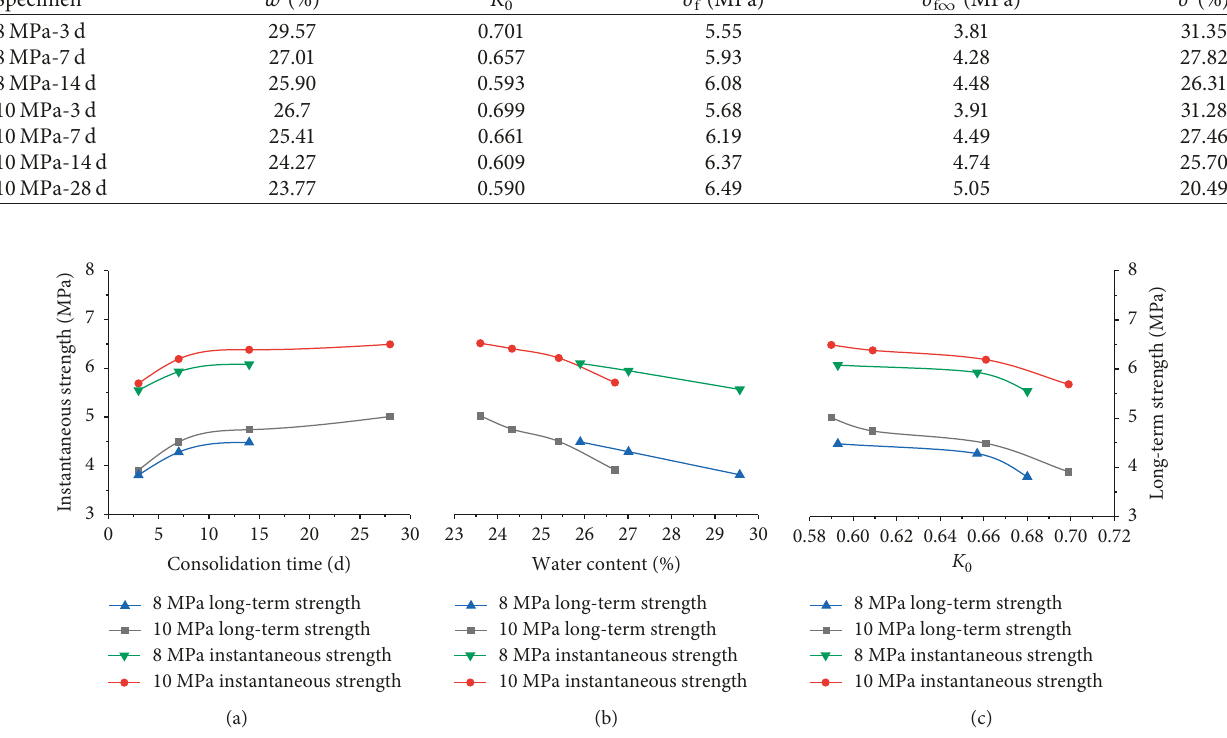
Figure 7: Variations in the long-term and instantaneous strengths of the frozen clay: (a) σ σ f ∞ vs. K 0 .